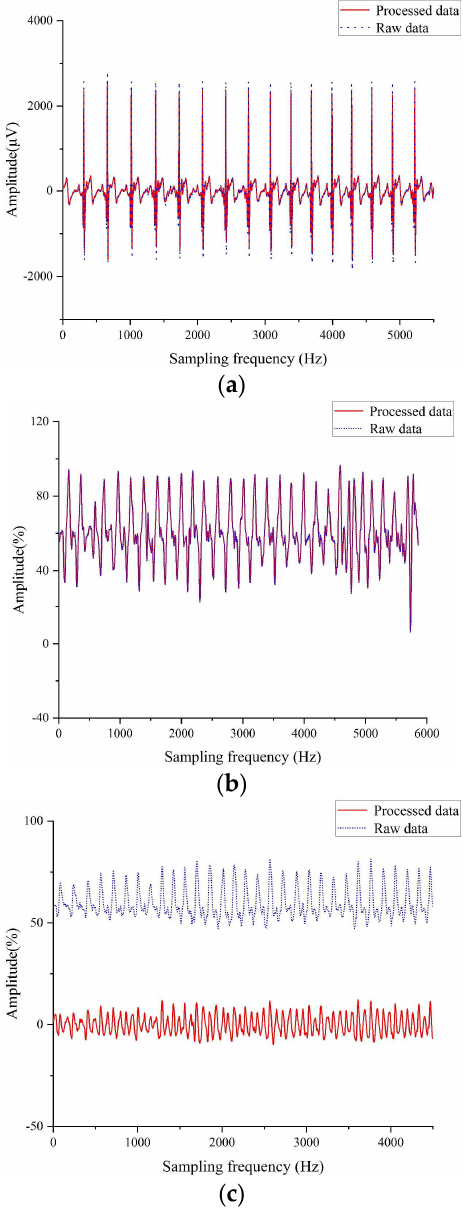
Figure 3. Diagram of the preprocessing of characteristic signals like ECG, EDA, and RESP. ( a ) Diagram of ECG filtering results, ( b ) Diagram of EDA filtering results, ( c ) Diagram of RESP filtering results. For any given segment B (cid:48) in a time series, S k and E k are the start and end position on i the time segment B (cid:48) , respectively. The middle position p mid of the time segment B (cid:48) i be calculated by Equation